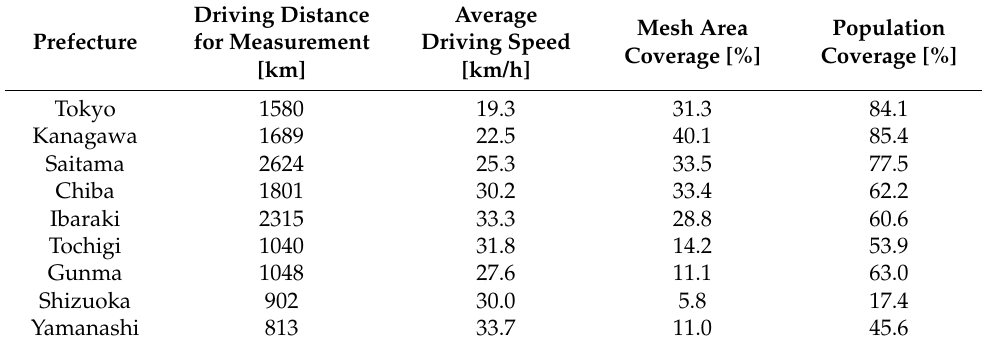
Table 3. Driving distance and coverage ratios in each prefecture in the measurement.